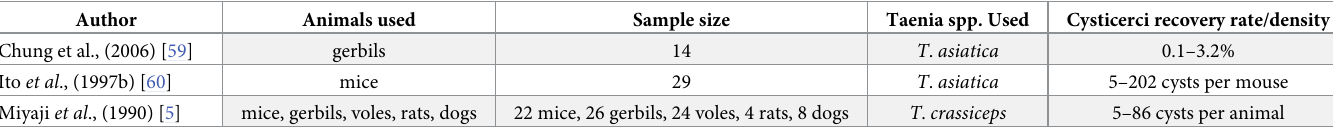
Table 3. Description of the animal models used in the included studies for T . asiatica and T . crassiceps